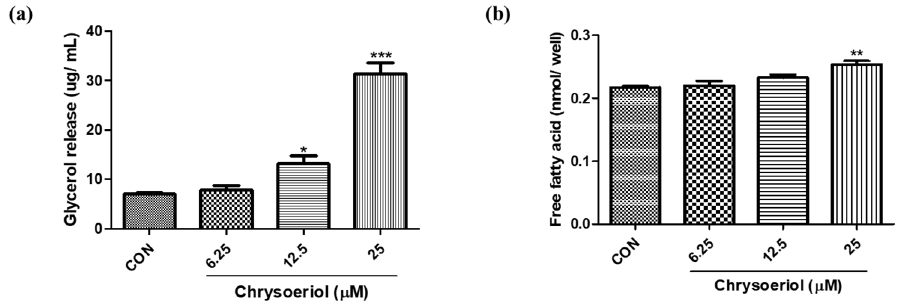
Figure 6. Effect of chrysoeriol on release of free glycerol ( a ) and free fatty acids ( b ) in 3T3-L1 adipo- cytes on day 7. *, **, *** p < 0.05, 0.01, and 0.001, respectively, significant difference compared with control group. CON, control (differentiated cells).